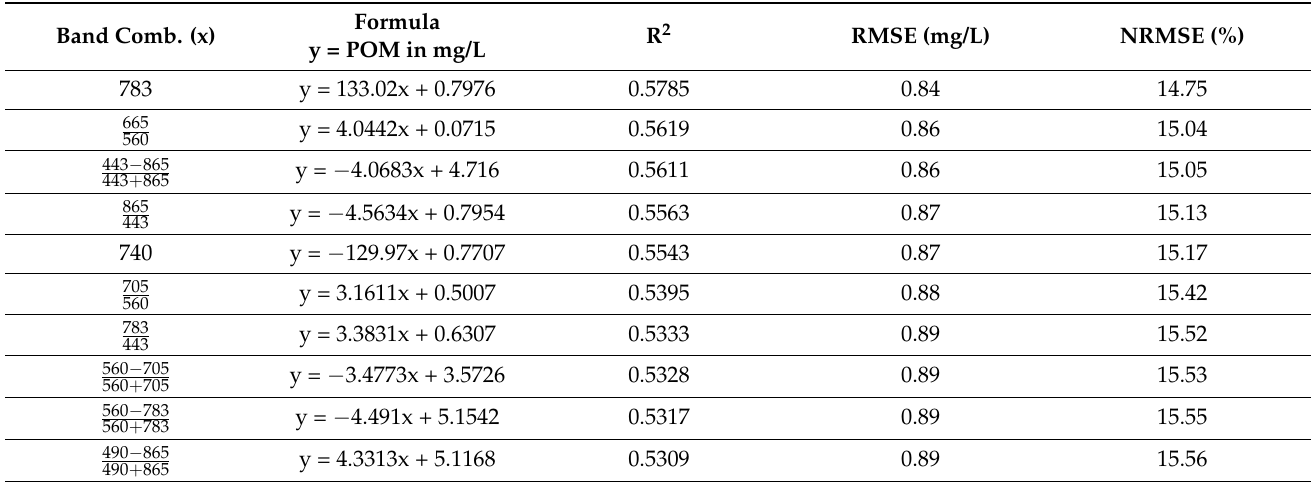
Table 3. Algorithm results for POM. Only the best 10 results are shown.